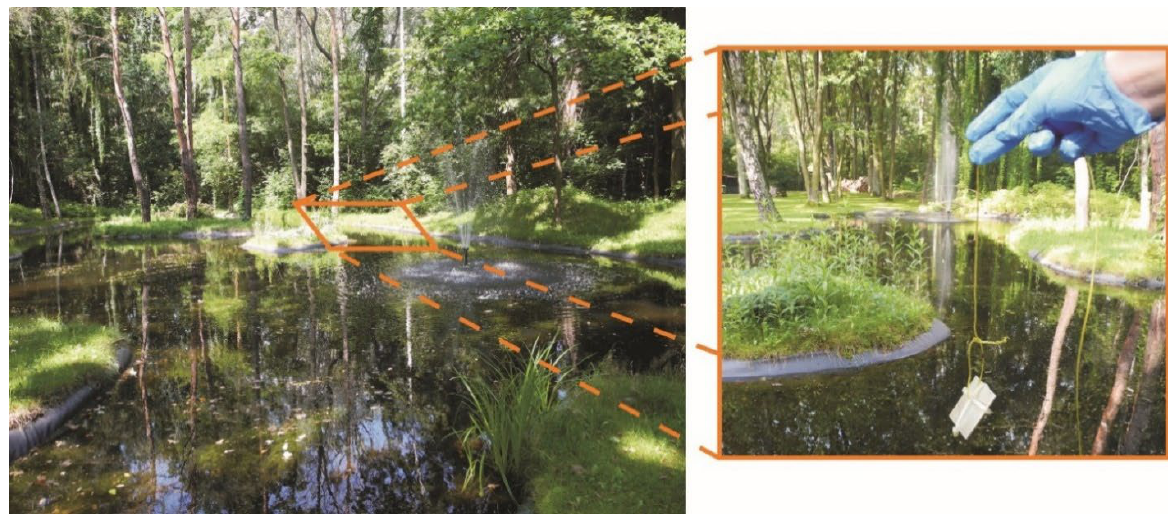
Figure 2. A test of antifouling properties in the pond.